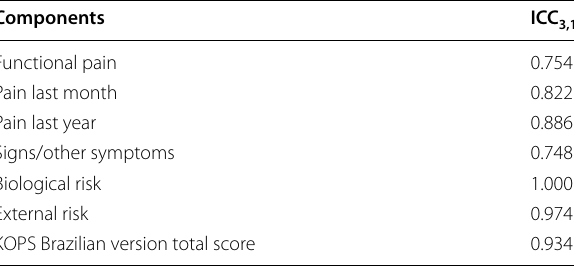
Table 3 Internal consistency and intra‑rater repeatability analyses for each component